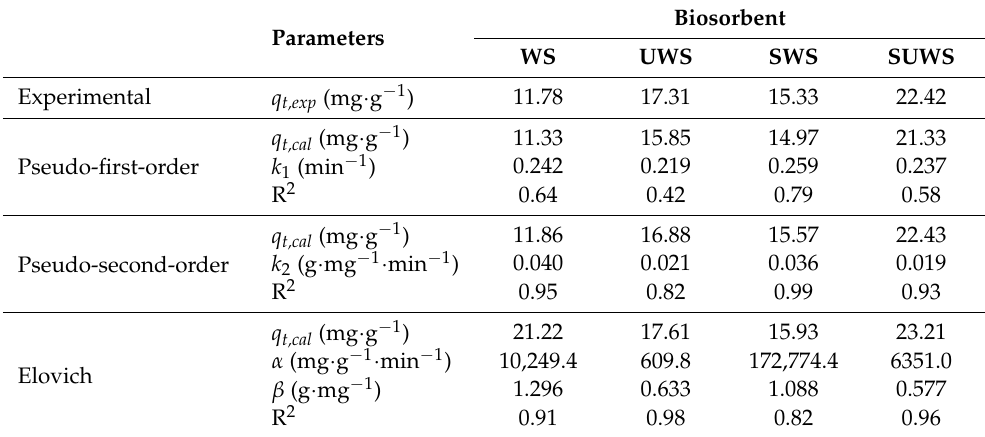
Table 6. Estimated kinetic parameters for adsorption of CV onto WS-based